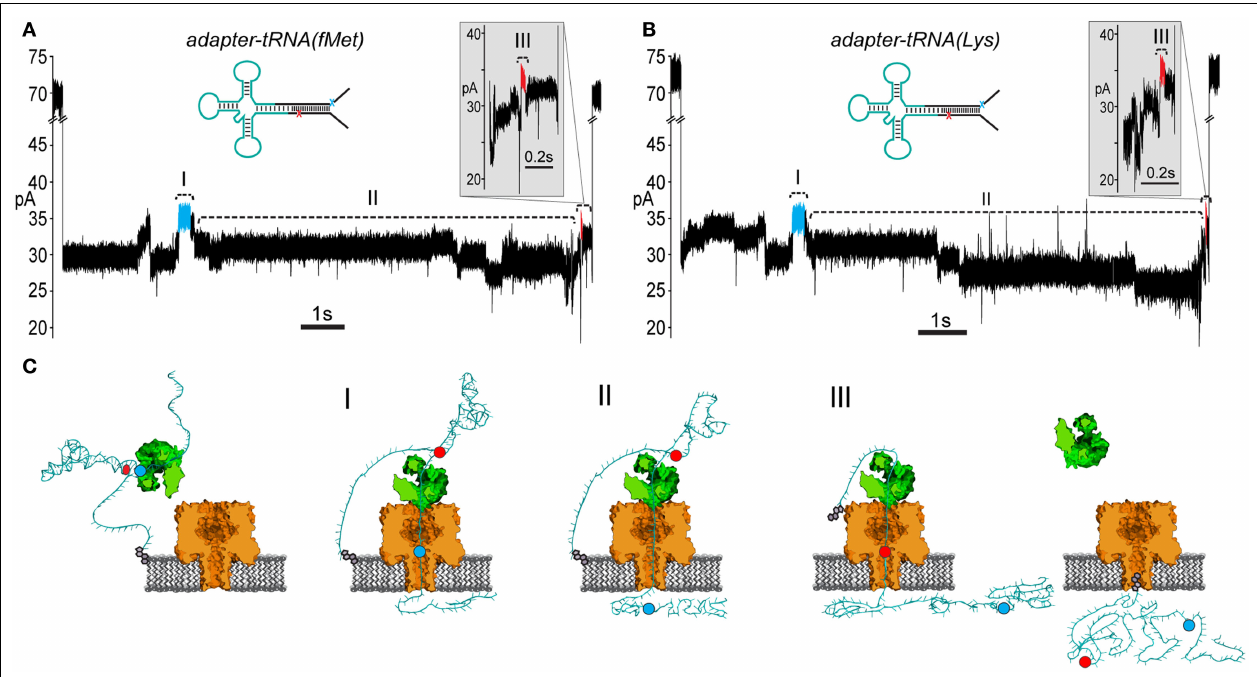
trailing 3 ′ high current marker. Scale bar indicates 0.1s. (B) A representative trace from nanopore experiments with adapted tRNA Lys . Details are the same as in (A) . (C) A cartoon model of an adapted tRNA as it transits the α -HL nanopore. The panels to the left and right correspond to open channel before and after tRNA translocation (see Figure 3 ). Roman numerals correspond to the roman numerals in (A,B) . (I) Translocation of the leading adapter strand through α -HL until the 5 ′ abasic residue (blue circle) reaches the pore limiting aperture. (II) Translocation of the tRNA portion of the adapted molecule. (III) Translocation of the trailing adapter strand and 3 ′ abasic residue (red circle) through the pore limiting aperture after translocation of the